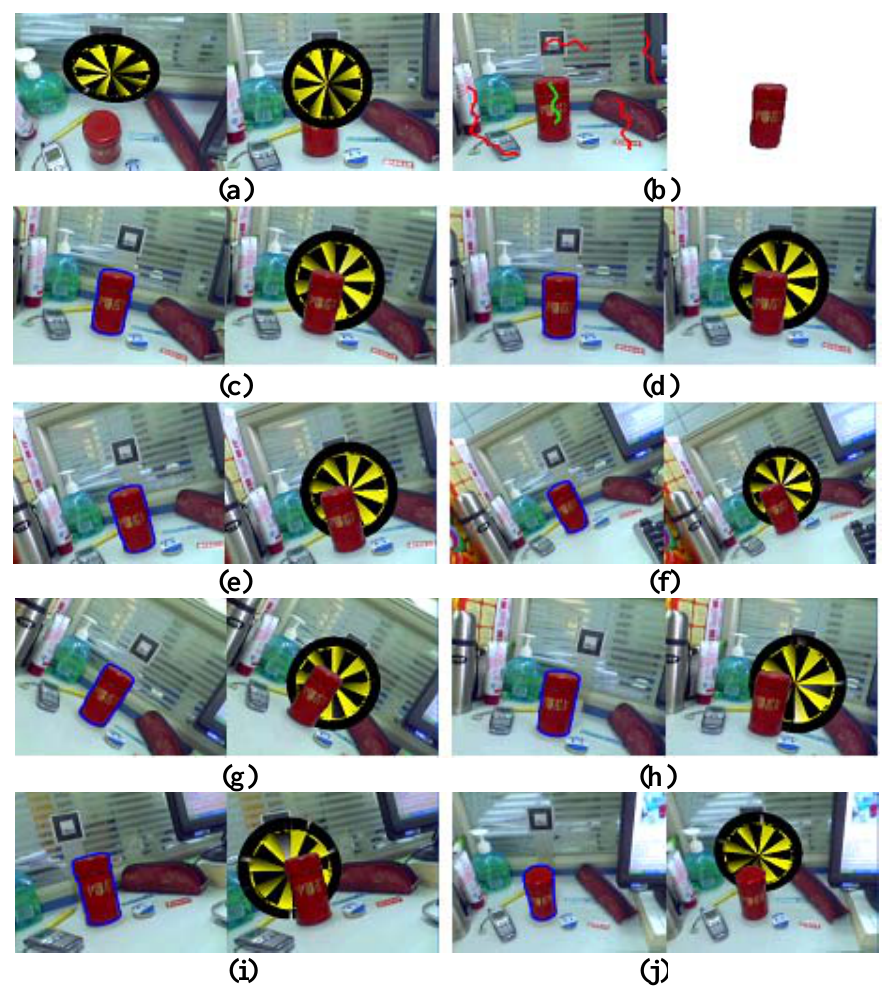
Figure 6. Results of the second